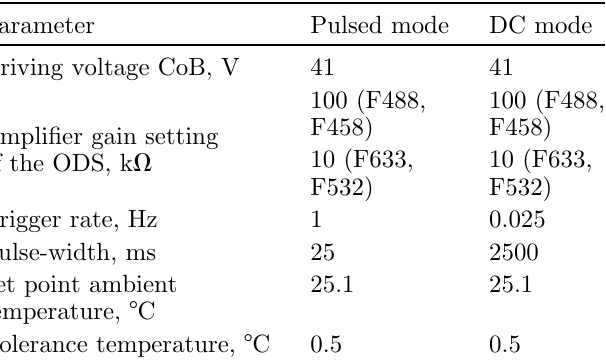
Table 4. Parameters of the pulsed and DC